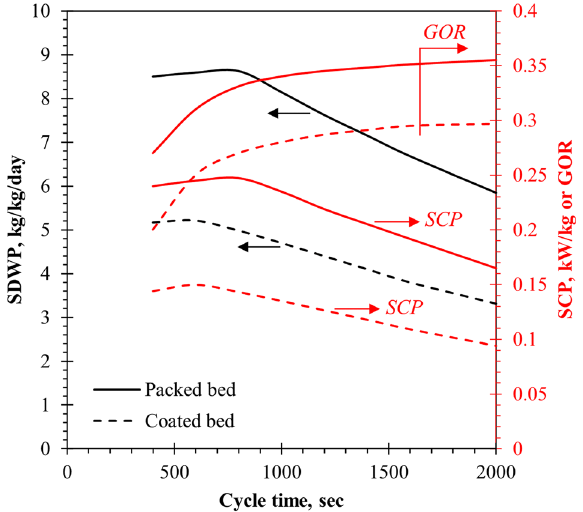
Fig. 3 SCP, SDWP, and GOR of the two sorption beds at different cycle times. SCP and SDWP of both adsorbents decline while GOP rise as the cycle time increases.